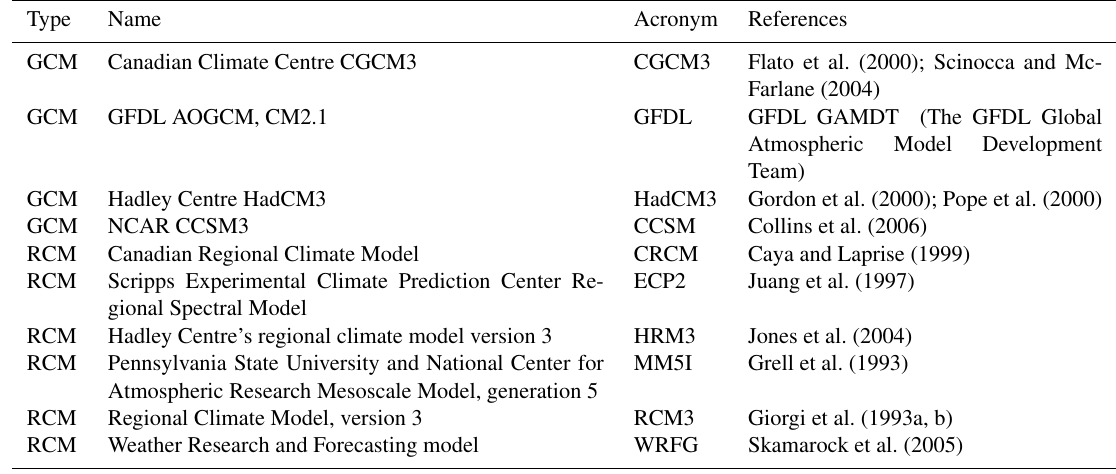
Table 1. Summary information for the GCMs and RCMs used in the second phase of the NARCCAP climate model experiment. Type